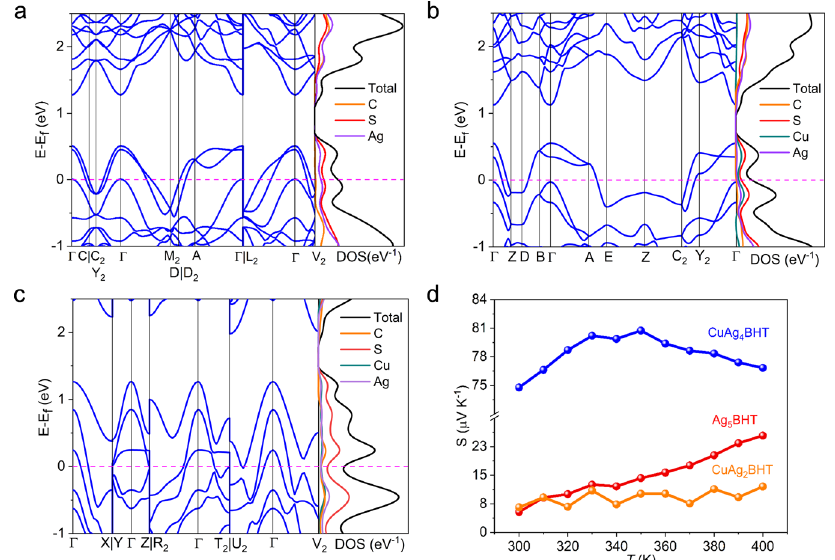
Fig.5|CalculatedelectronicstructuresandSeebeckcoef fi cientmeasurements. a – c Calculated band structures and DOS for Ag 5 BHT ( a ), CuAg 4 BHT ( b ), and CuAg 2 BHT ( c ). The high-symmetryK-points in the fi rst Brillouin zone are provided